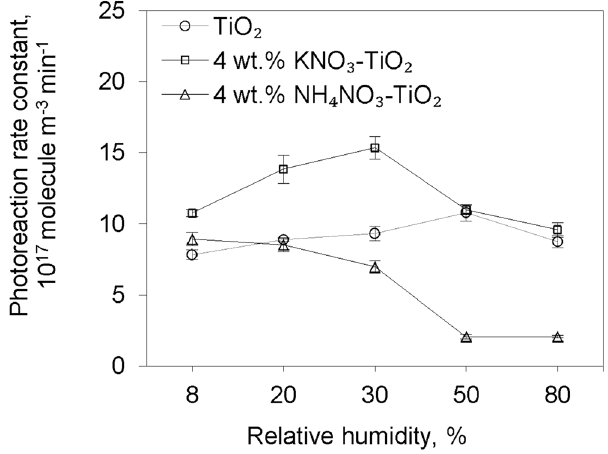
Figure 4. Variations of photoreaction rate constants with relative humidity. Formaldehyde photoreaction rate constants on